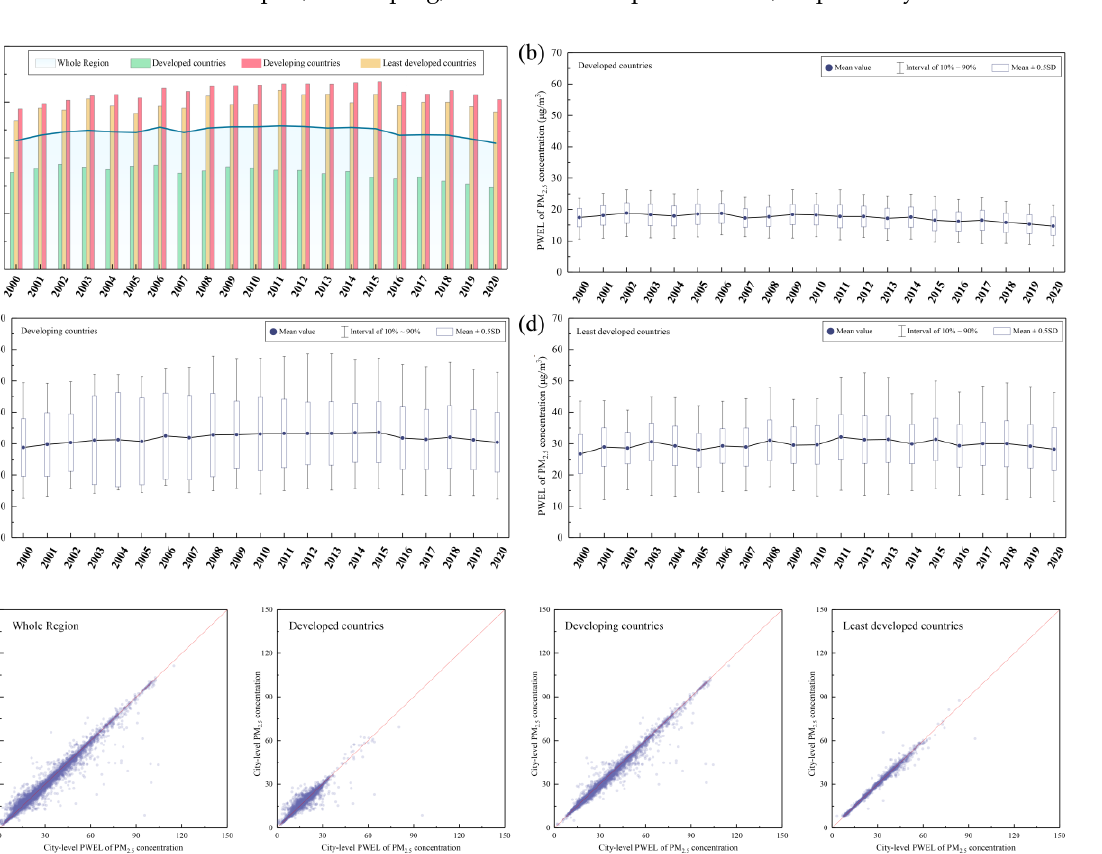
Figure 5. The temporal trends of ( a ) annual mean PWEL of PM 2.5 concentration in the whole region, distribution of city-level PWEL of PM 2.5 concentration in ( b ) developed countries, ( c ) developing countries, ( d ) least developed countries. ( e ) comparison between PM 2.5 concentration and PWEL of PM 2.5 concentration at city level.